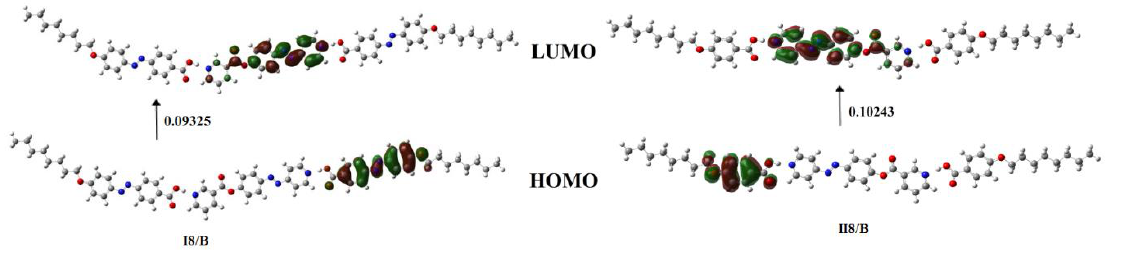
Figure 8. The estimated plots for frontier molecular orbitals of I8/B and II8/B . Molecules 2020 , 25 , x FOR PEER REVIEW